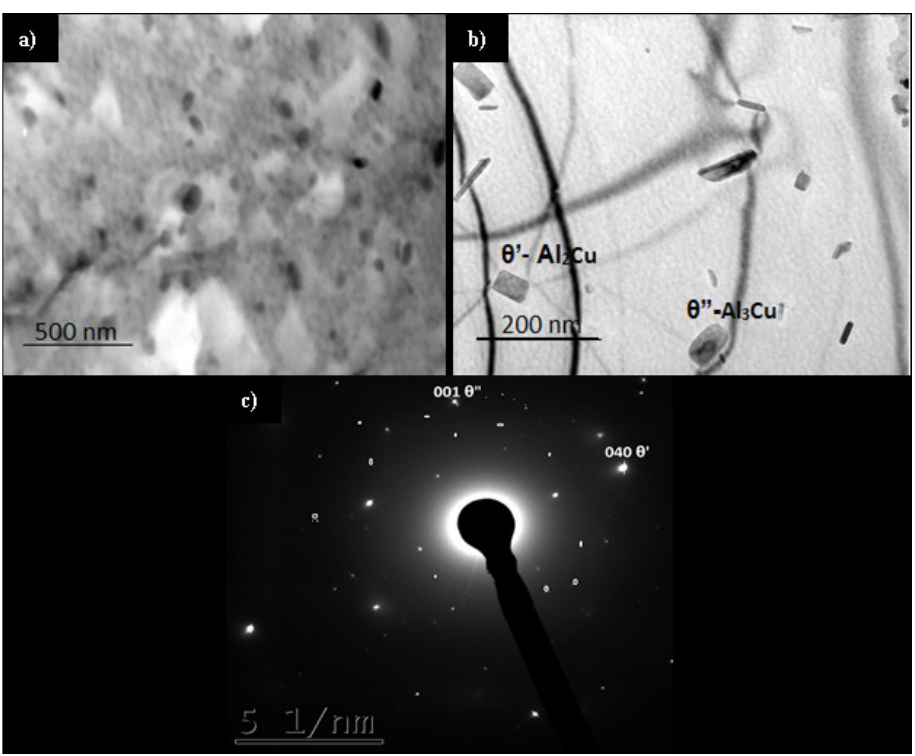
composite aged at 100°C shows presence of θ” phase 2